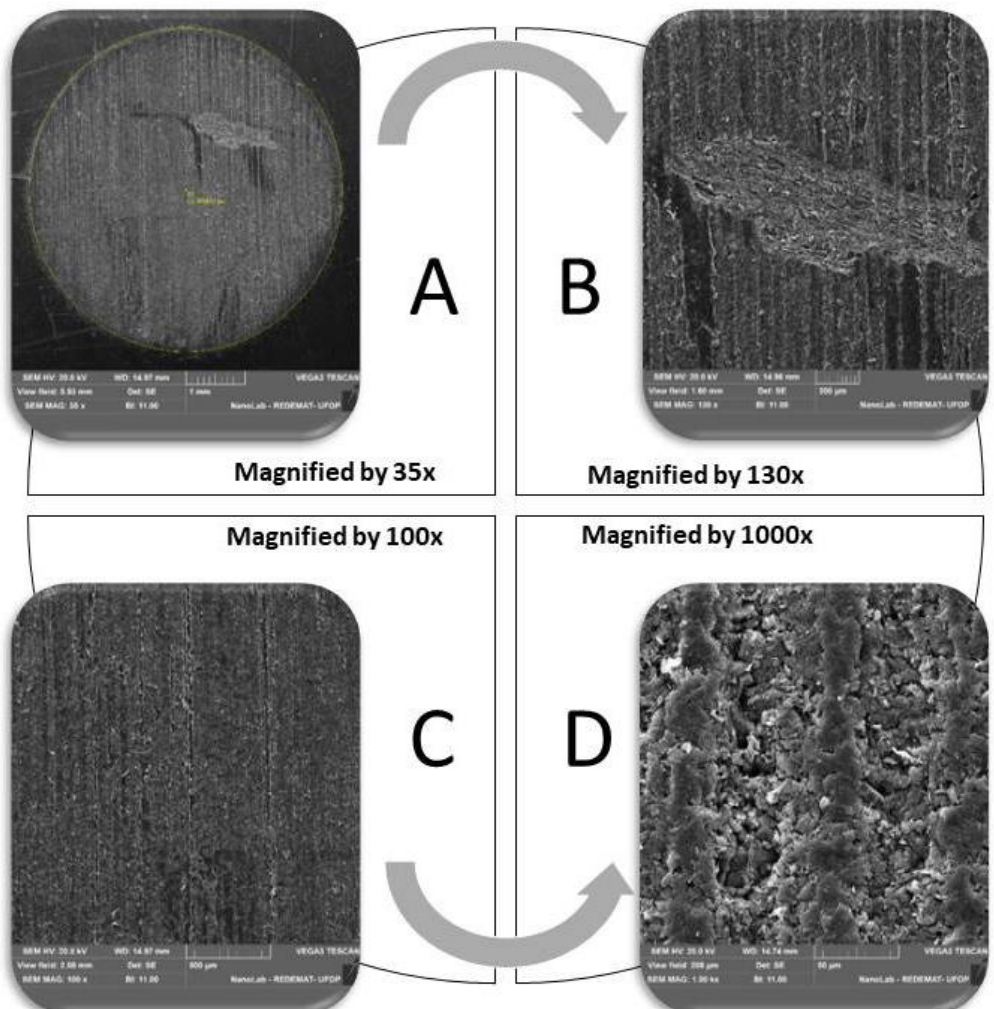
Figure 6. Magnified by ( A ) 35×, ( C ) 100×, ( B ) 130×, and ( D ) 1000×. Evaluation of micro-abrasive wear in inclusions using the SEM technique.